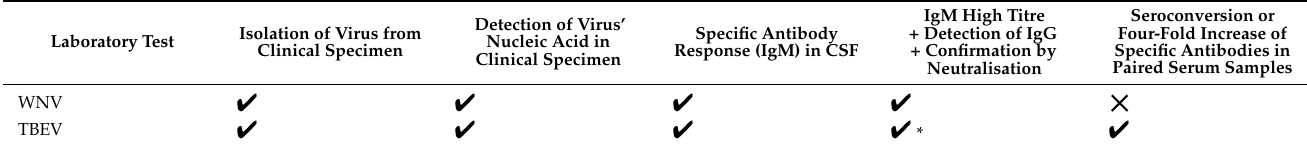
Table 1. Required laboratory criteria for the case confirmation according to the Commission Imple- menting Decision (EU) 2018/945 on communicable diseases. At least one of the following criteria needs to be fulfilled.